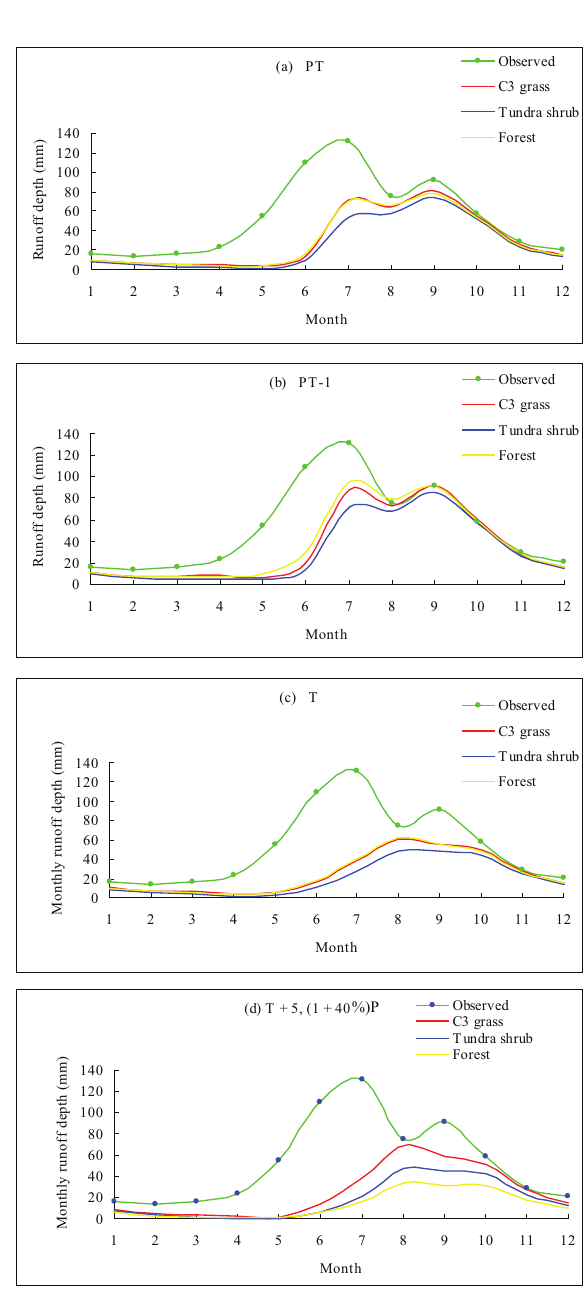
Figure 6. Five-year mean monthly runoff depth during the three periods: (a) PT run; (b) PT-1 run; (c) T